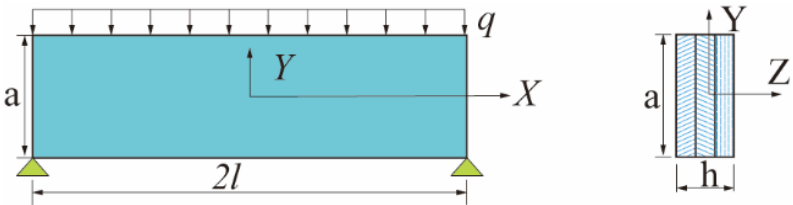
Figure 6. Loading diagram of simply supported laminate beam. Since σ y is caused by the lateral load q , and q is a fixed value, which means that σ y is